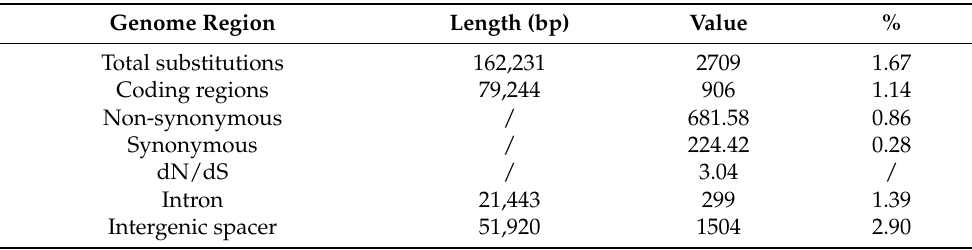
Table 5. Genomic distribution of biallelic single nucleotide polymorphic loci in the eight chloroplast genomes of diploid Gossypium